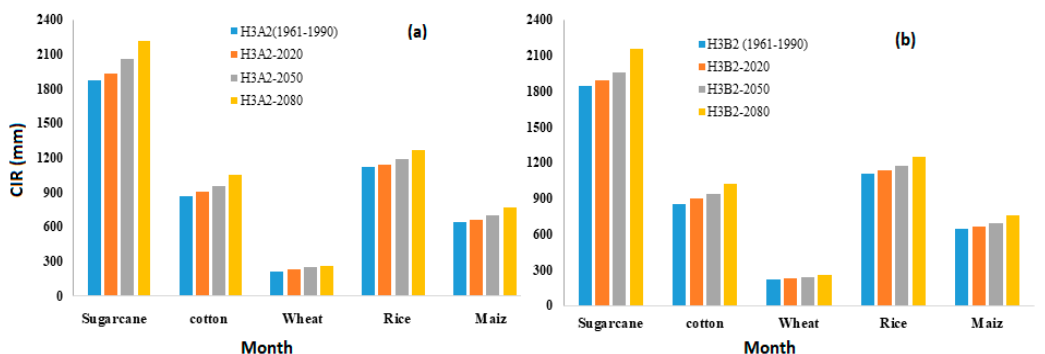
Figure 10. Changes in crop irrigation requirement (CIR) of different agricultural crops under ( a ) H3A2 and ( b ) H3B2 scenarios in Rechna Doab.